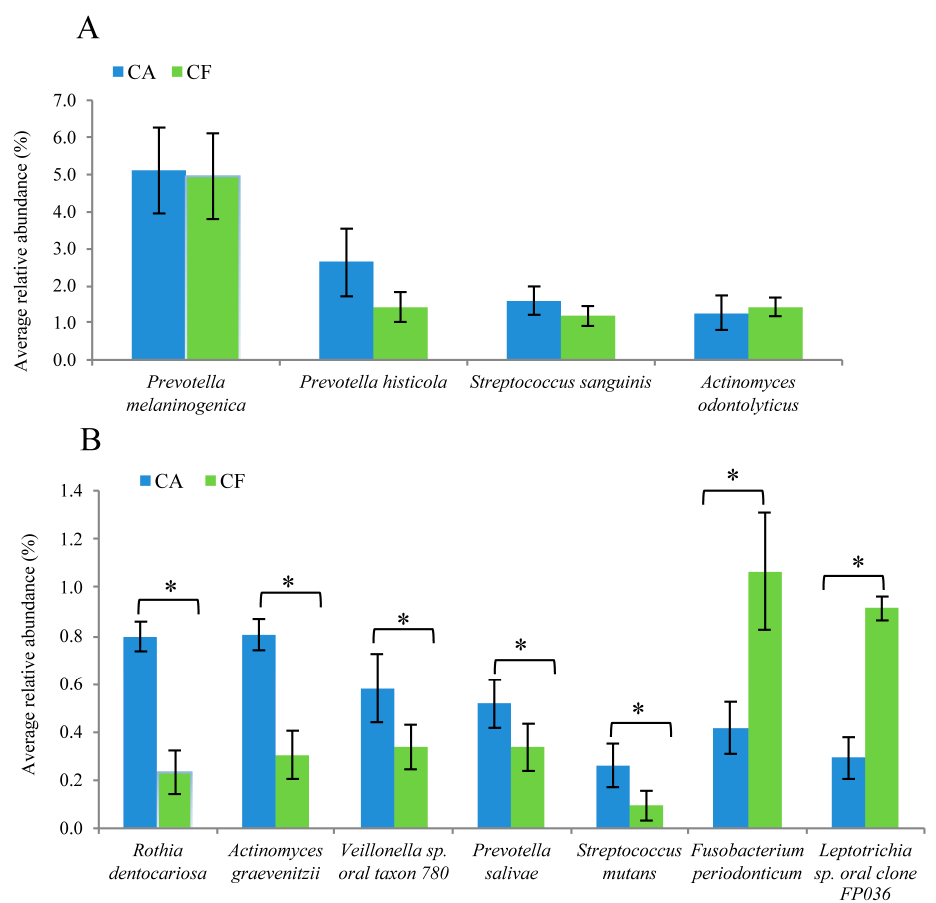
Figure 7. Comparison of the bacterial composition between the caries-affected (CA) and caries-free (CF) groups at the species level. ( A ) The predominant species in both CA and CF groups; ( B ) Bacterial species significantly more prevalent in the CA or CF groups (* p < 0.05).